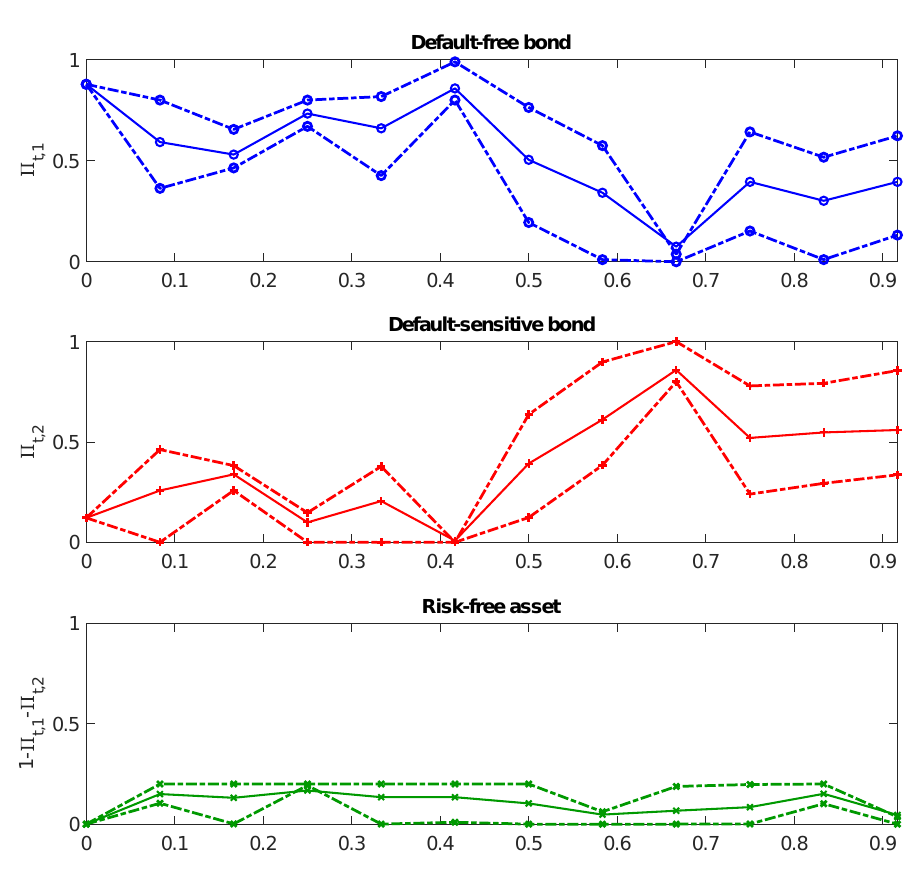
Figure 2. Empirical mean: 25% and 75% quantiles of the optimal proportions invested in the default- free bond ( up ), default-sensitive bond ( middle ), and risk-free asset ( bottom ). We analyze the performance of the obtained optimal strategies when the latter are applied to sampled paths of the state process. 7 Figure 3 compares the optimal penalized Π ) − θ [( CL − X Π ) + ] 2 (upper left side), asset values X Π utilities of wealth U ( X t t t Π right side), and asset-liability ratios X / L t (bottom) at each date t 0 , t 1 , · · · , t m with the t corresponding values obtained when (i) using the risk-free asset only (referred to as the “risk-free strategy”) and (ii) when proportions in the three assets are fixed to a constant value over time (10% in the risk-free asset, 40% in the default-free bond, and 50% in the default-sensitive bond, referred to as the “fixed-proportion strategy”). We observe that the optimal strategy, on average, outperforms the fixed-proportion and risk-free strategies, and exhibits lower variability than the fixed-proportion strategy. The negative trend in asset Π portfolio values X is due to the surrender payments in each period, i.e., the positive term t − Y Y t t k − 1 in k